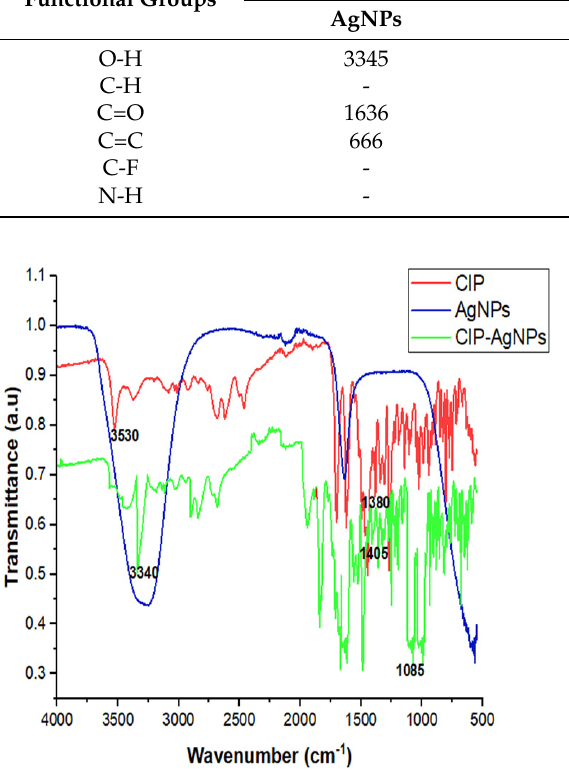
Table 1. FTIR wavenumbers of CIP, AgNPs and CIP-AgNPs. Functional Groups